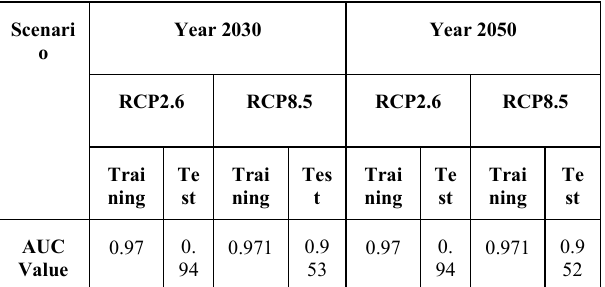
Table 3. AUC value for year 2030 and 2050